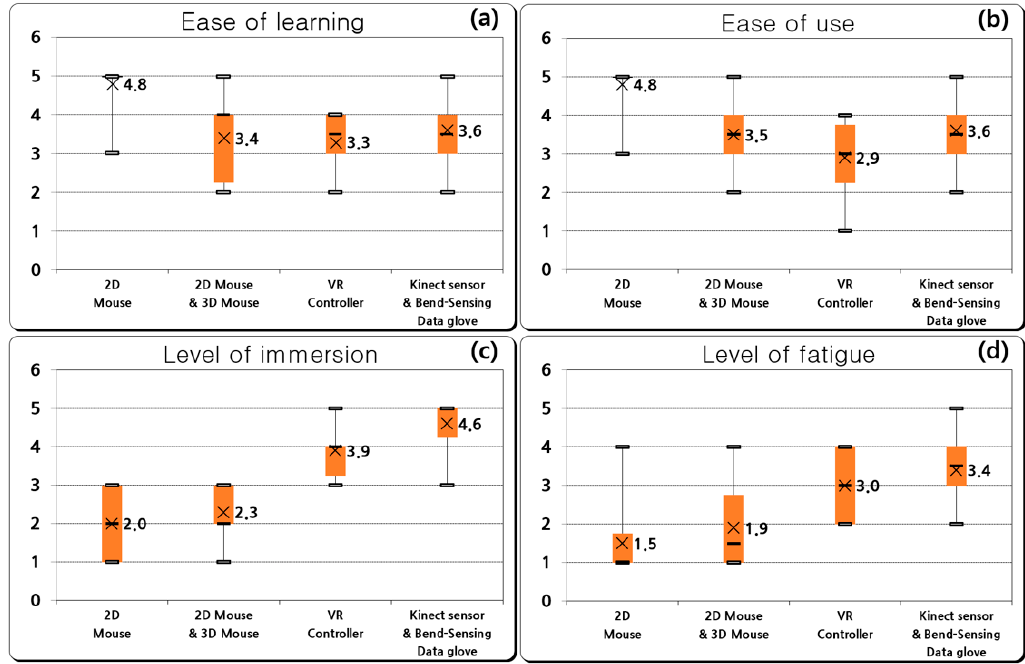
Figure 7. Questionnaire survey results for users controlling KmodStudio in a virtual reality (VR) environment using different user interface devices. ( a ) Ease of learning; ( b ) ease of use; ( c ) level of immersion; and ( d ) level of fatigue.